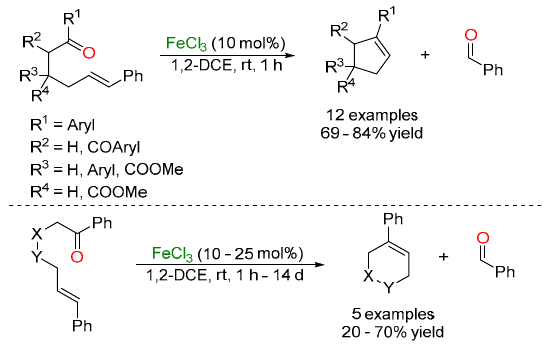
Scheme 13. General equations of the published reactions by Li.